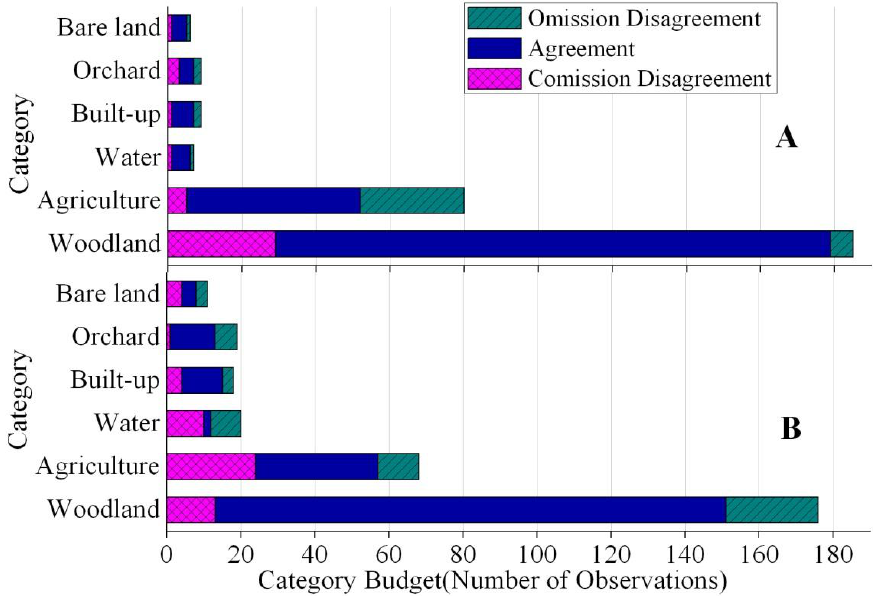
Figure 5. Category level analysis of agreement, omission disagreement and commission disagreement for LULC maps of 2002 classified by ( A ) stratified and ( B ) unstratified